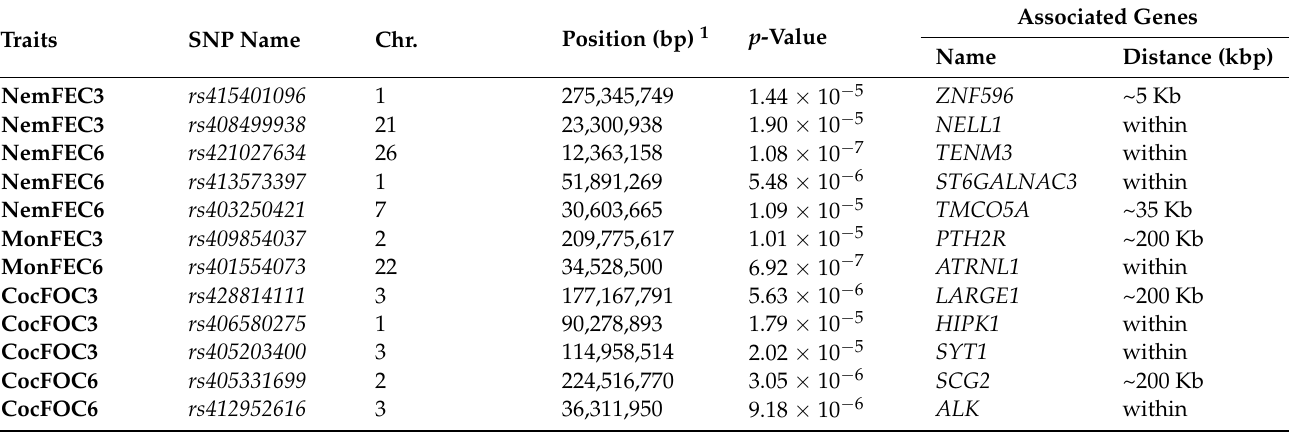
Table 2. Significant SNP associated with parasite resistance